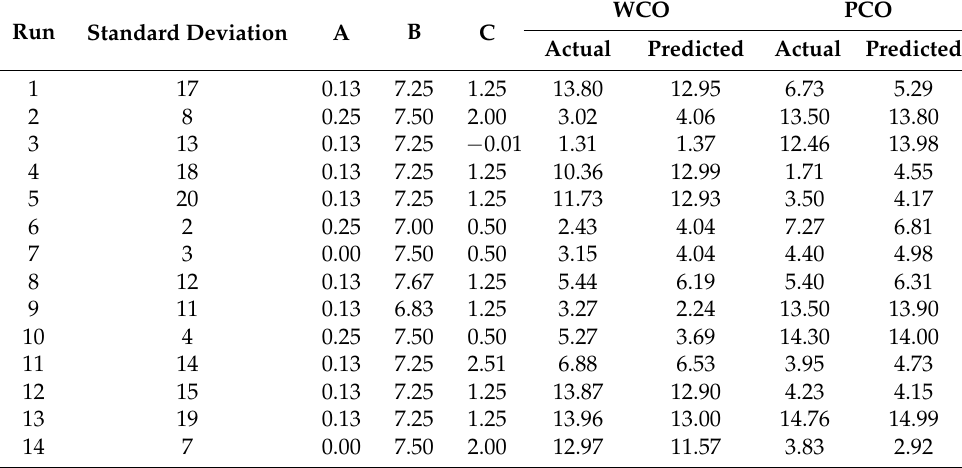
Table 7. Central composite experimental design for biosurfactant production by BS14 bacterial consortium using either WCO or PCO as